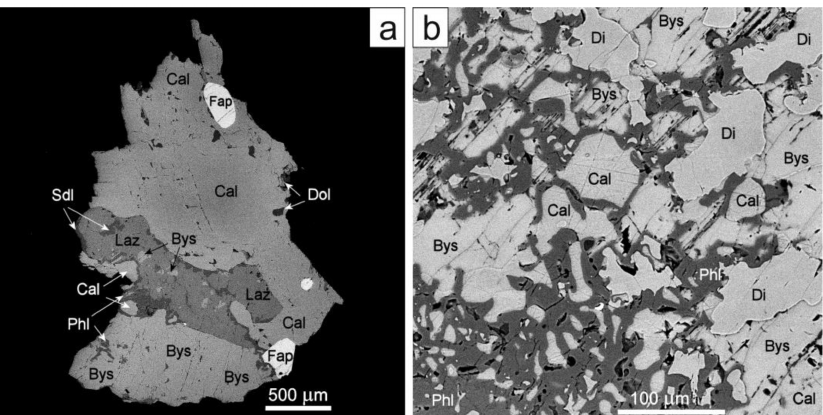
Figure 2. Mineral associations of bystrite (Bys, Sample 9) with lazurite (Laz), sodalite (Sdl), calcite (Cal), dolomite (Dol), fluorapatite (Fap), phlogopite (Phl) and diopside (Di): fragments of the coarse- grained ( a ) and fine-grained ( b ) zones of the specimen. SEM (BSE) images of polished